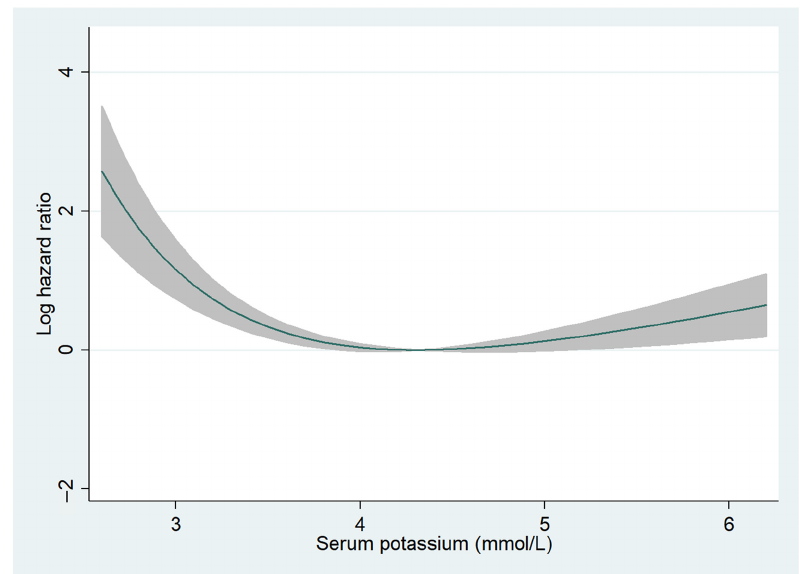
Figure 1. Fractional polynomials for serum potassium levels and 2-year all-cause mortality. The relationship between serum potassium levels and 2-year all-cause mortality is shown. The Y-axis indicates log hazard ratio. The shaded areas represent 95% confidence intervals.